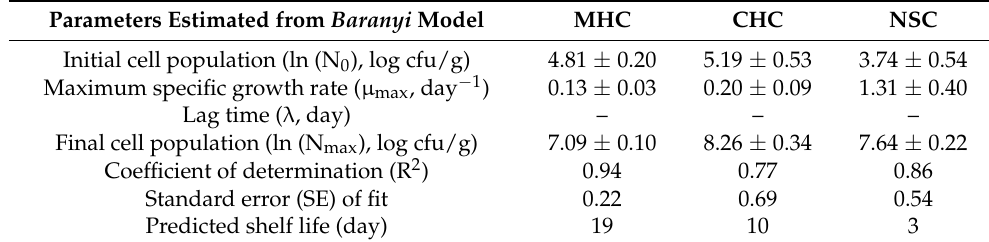
Table 2. Predicted shelf life and calculated model parameters for modelling the total viable count growth of sausages with different